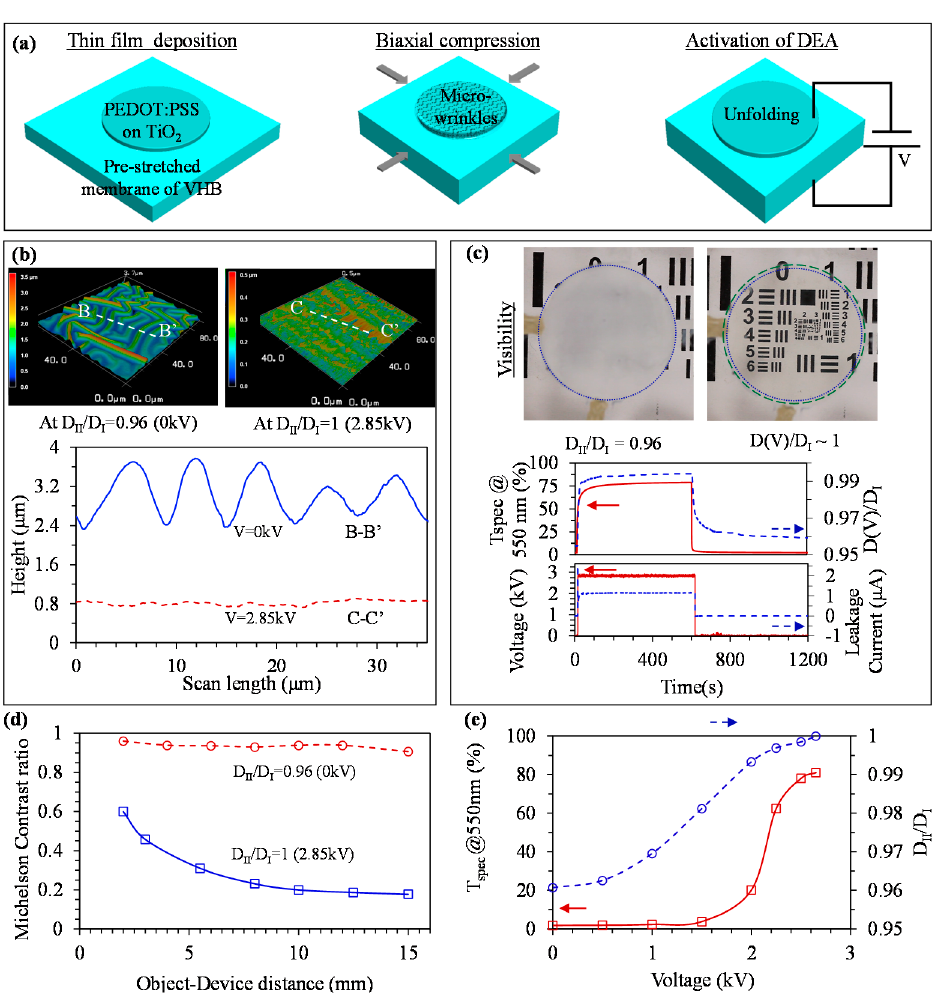
Figure 6. Voltage-controlled unfolding of a microwrinkled surface of the DEA-based transparency tuning device (coating layers of 39.79 nm PEDOT:PSS and 19.79 nm TiO 2 ). ( a ) Schematic showing formation of microwrinkles and change in device area and the surface upon voltage activation; ( b ) 3D confocal images and 2D profile of the same device at different active and inactive states; ( c ) corresponding appearance of a USAF target placed 10 mm beneath the device, its on-off time response in terms of inline transmittance and electrode diameter change and corresponding voltage and current; ( d ) change Michelson contrast ratio of the USAF target placed at varying distance from the device at On and Off states; ( e ) gradual change in inline transmittance (T spec ) induced by an electrically obtained change in compression states (D II /D I ).